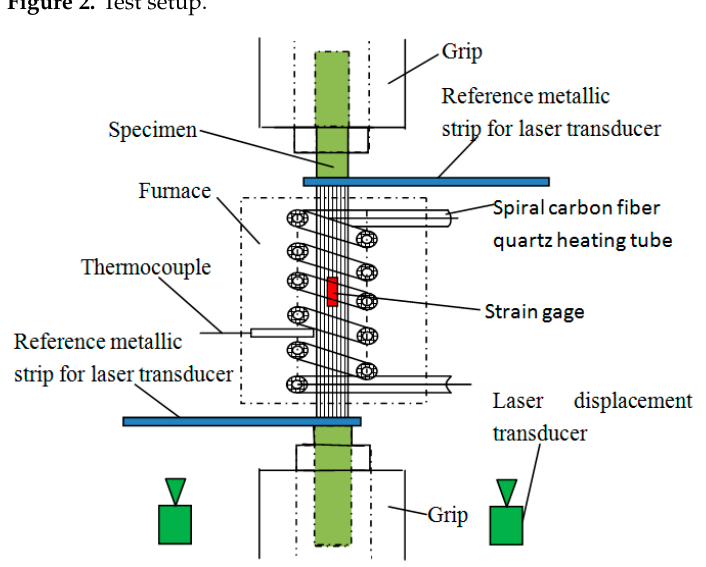
Figure 3. High-temperature electric furnace and specimen deformation measurement method details.